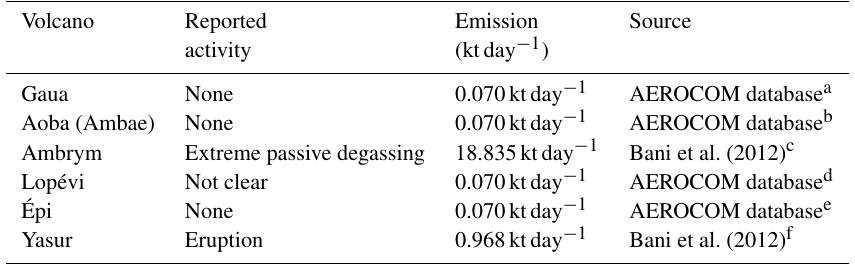
Table 2. SO 2 emission rates in January 2005 from the principal active volcanoes on Vanuatu (Gaua, Aoba, Lopévi, Épi, Ambrym, Yasur) as prescribed in the simulations. Details for each volcano are given in the footnotes to the